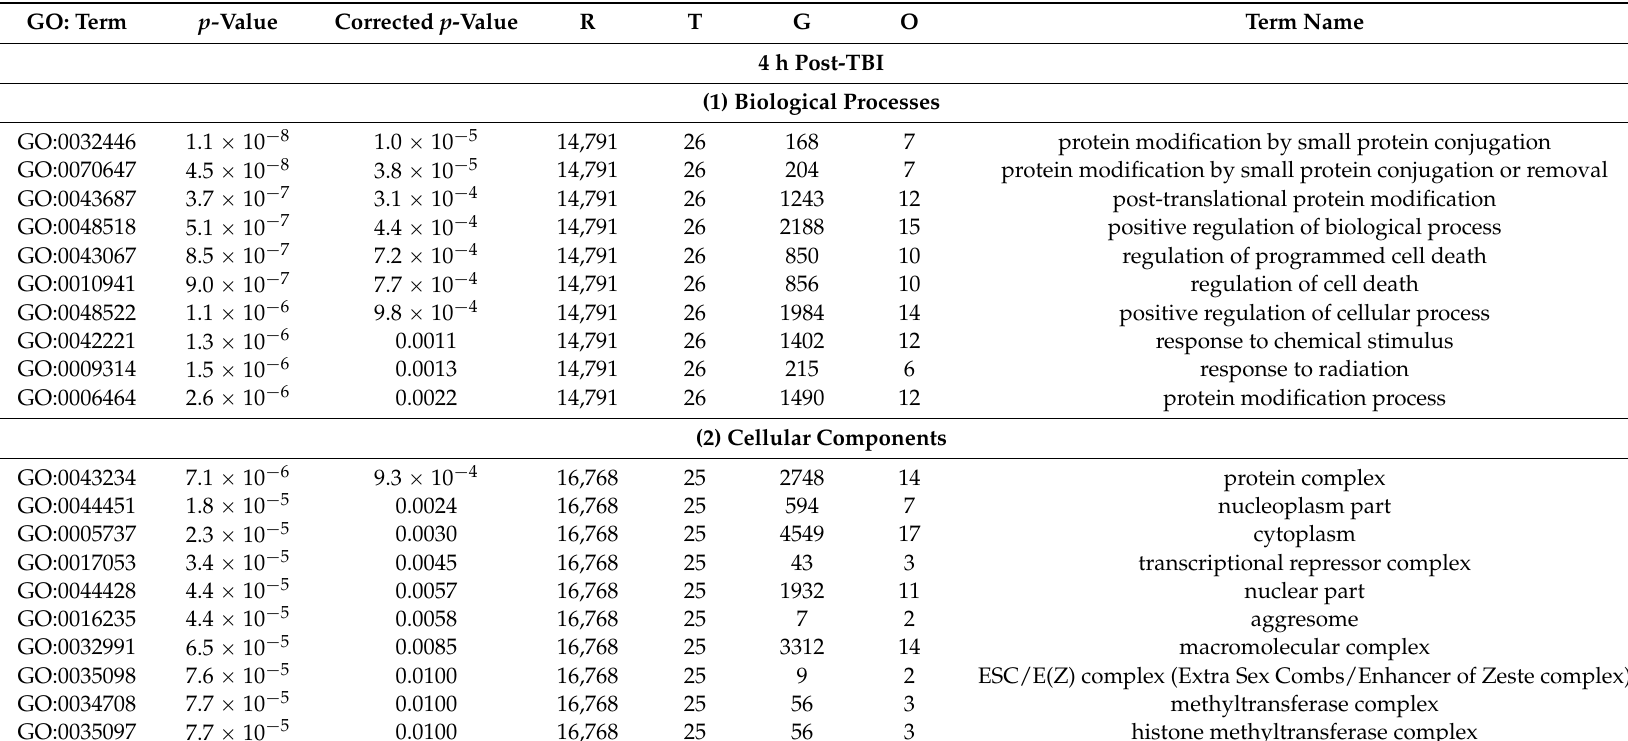
Table 4. Network ontology pathway analysis and gene set enrichment analysis for four time points post-TBI with respect to (1) biological processes; (2) cellular components; and (3) molecular functions. Each of these tables is presented for each of the four time points. R: number of genes in reference set; T: number of genes in test set; G: number of genes annotated by given term in reference set; O: number of genes annotated by given term in test set. This table is produced based on data stored in the network ontology analysis (NOA) web